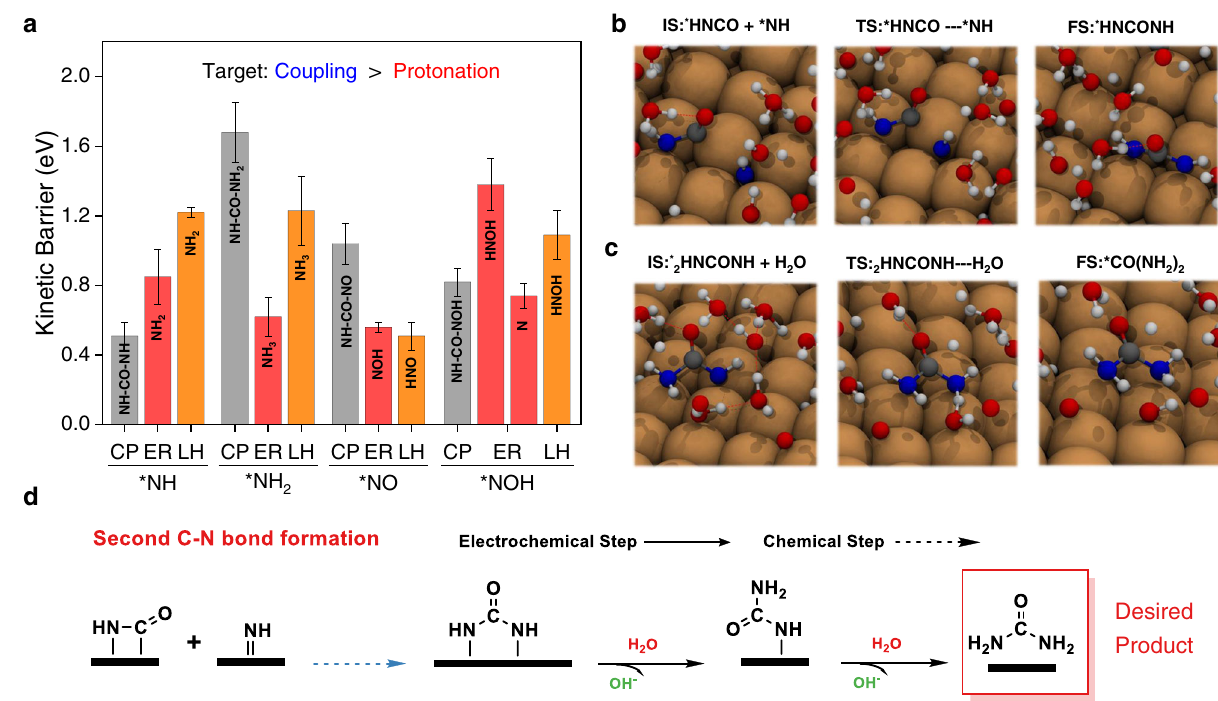
Fig. 4 | The second C-N bond formation.a Comparison of the coupling of various nitrogenous intermediates with * CO-NH and protonation. Snapshots of reactive trajectories for b * NHCO coupling with * NH, c * NH 2 CONH protonation to urea.